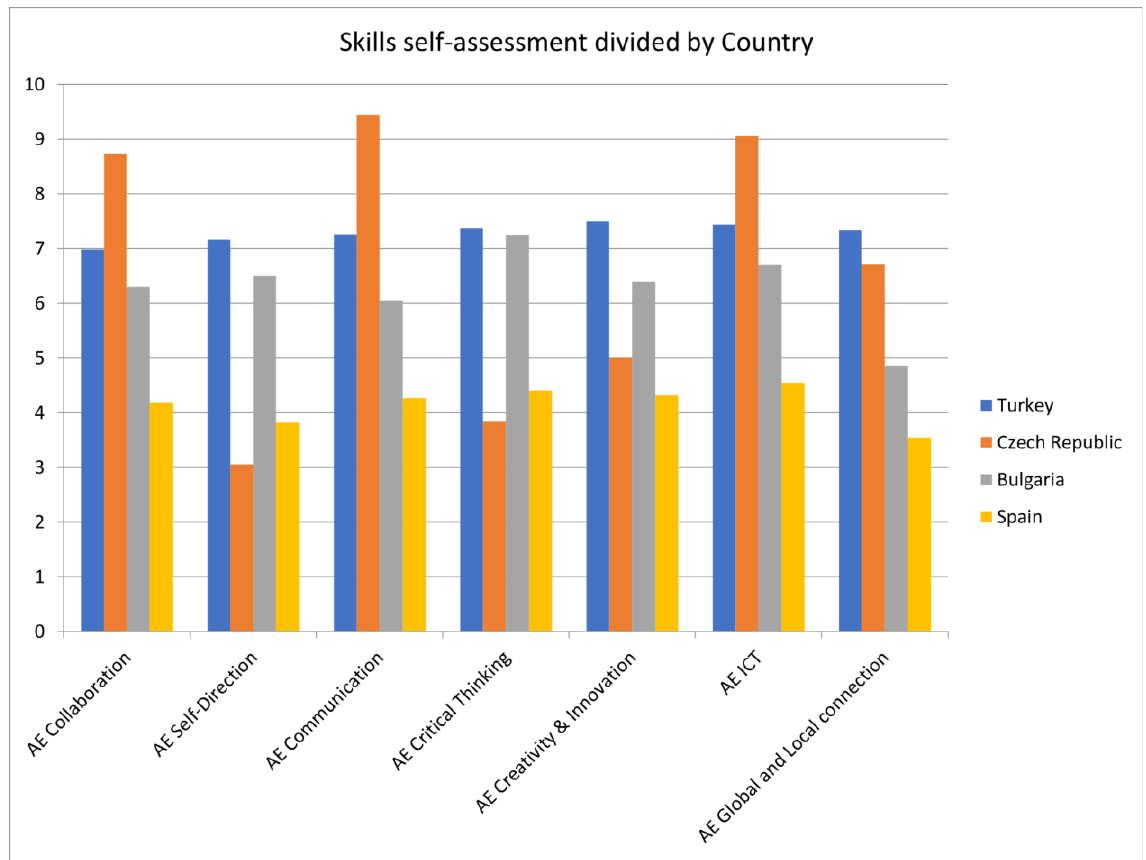
CHART 3. SKILLS SELF - ASSESSMENT ACCORDING TO